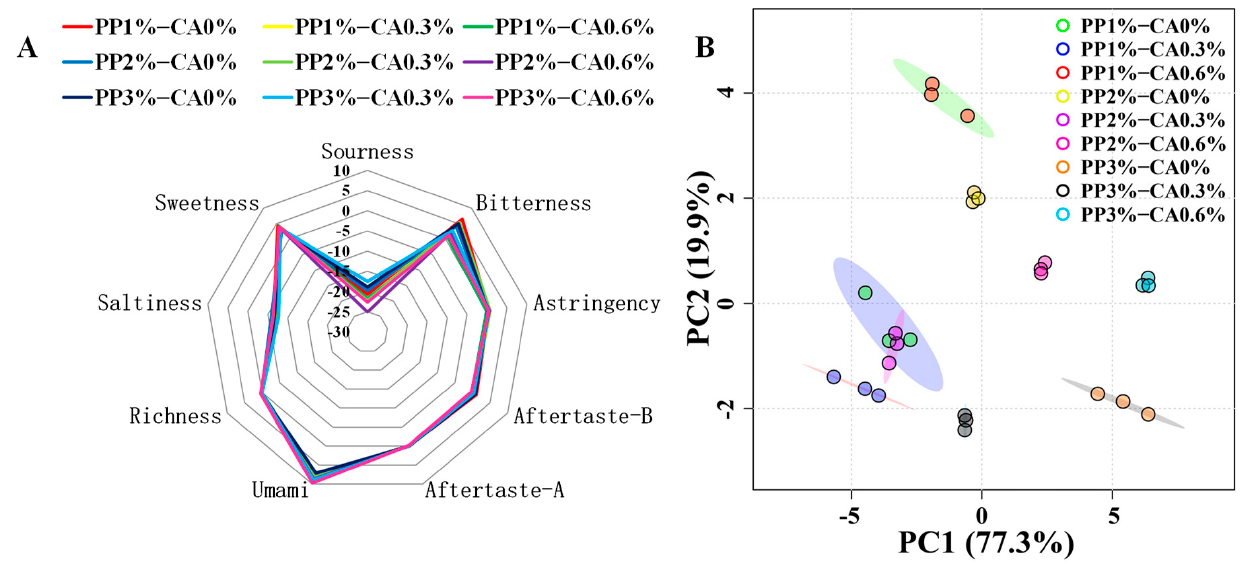
Figure 9. E-tongue result of the heat-treatment product: ( A ) is the E-tongue radar chart of the heat-treated product, and ( B ) is the PCA analysis of heat-treatment products.